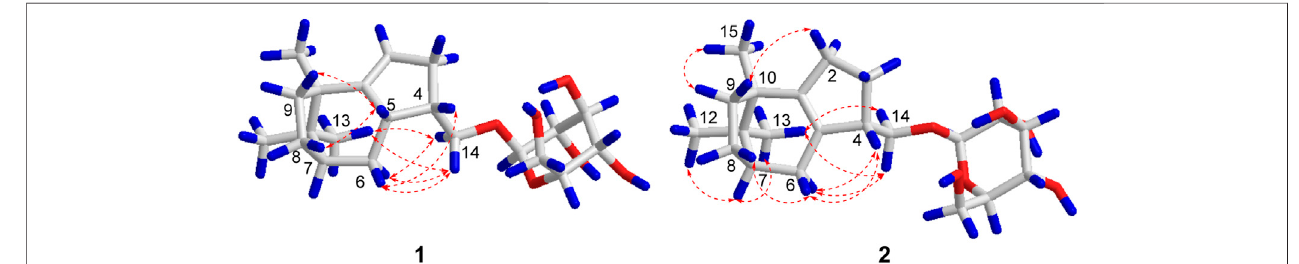
FIGURE 2 | Key NOESY correlations of compounds 1 and 2